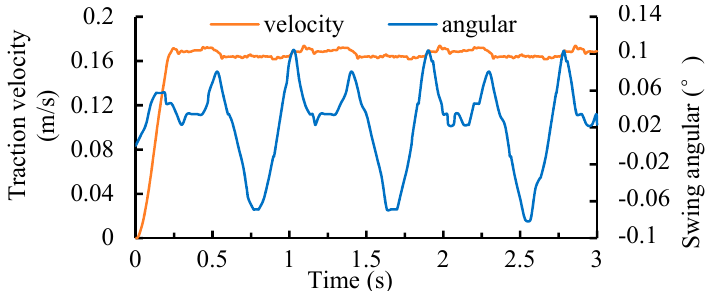
Figure 2. The traction velocity and swing angle.